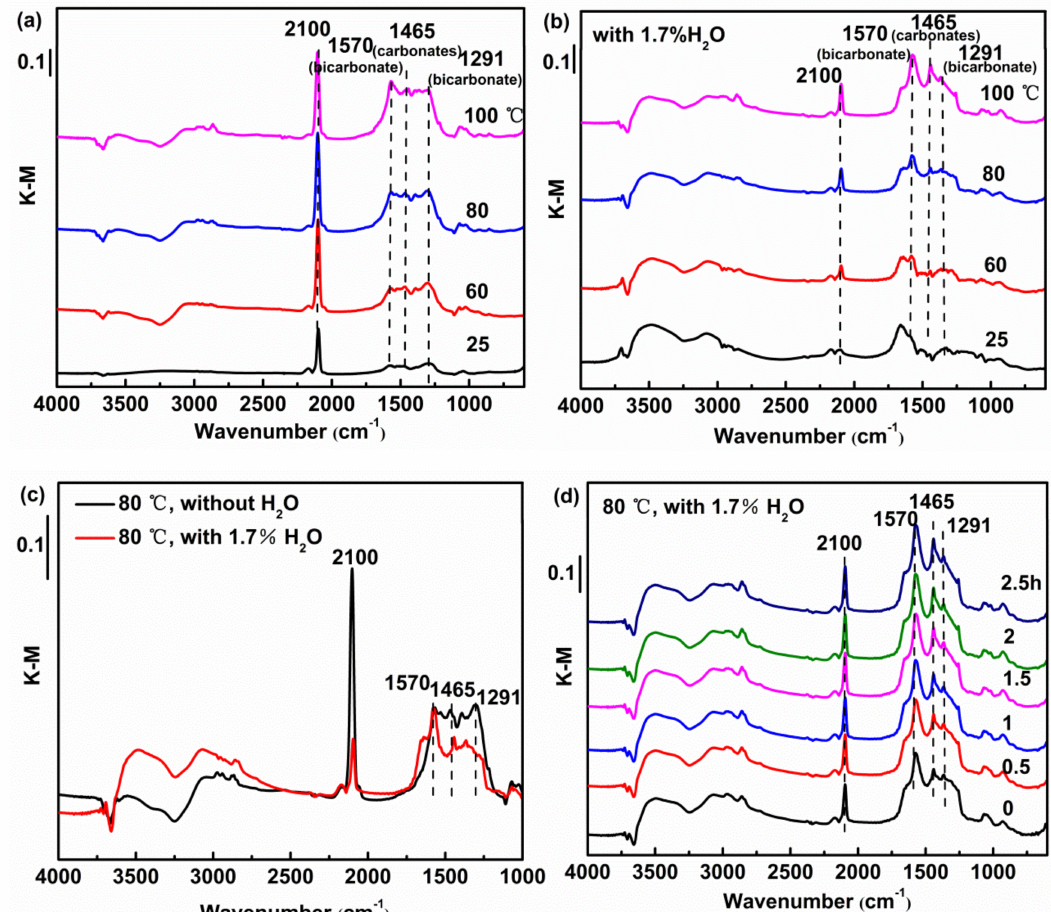
Figure 8. In situ DRIFT spectra of the 14% CuCe sample: ( a ) without water vapor from 25 to 120 ◦ C; ( b ) with water vapor from 25 to 120 ◦ C; ( c ) the comparison of CO catalytic oxidation with water vapor and without water vapor at 80 ◦ C; ( d ) time evolution with water vapor at 80 ◦